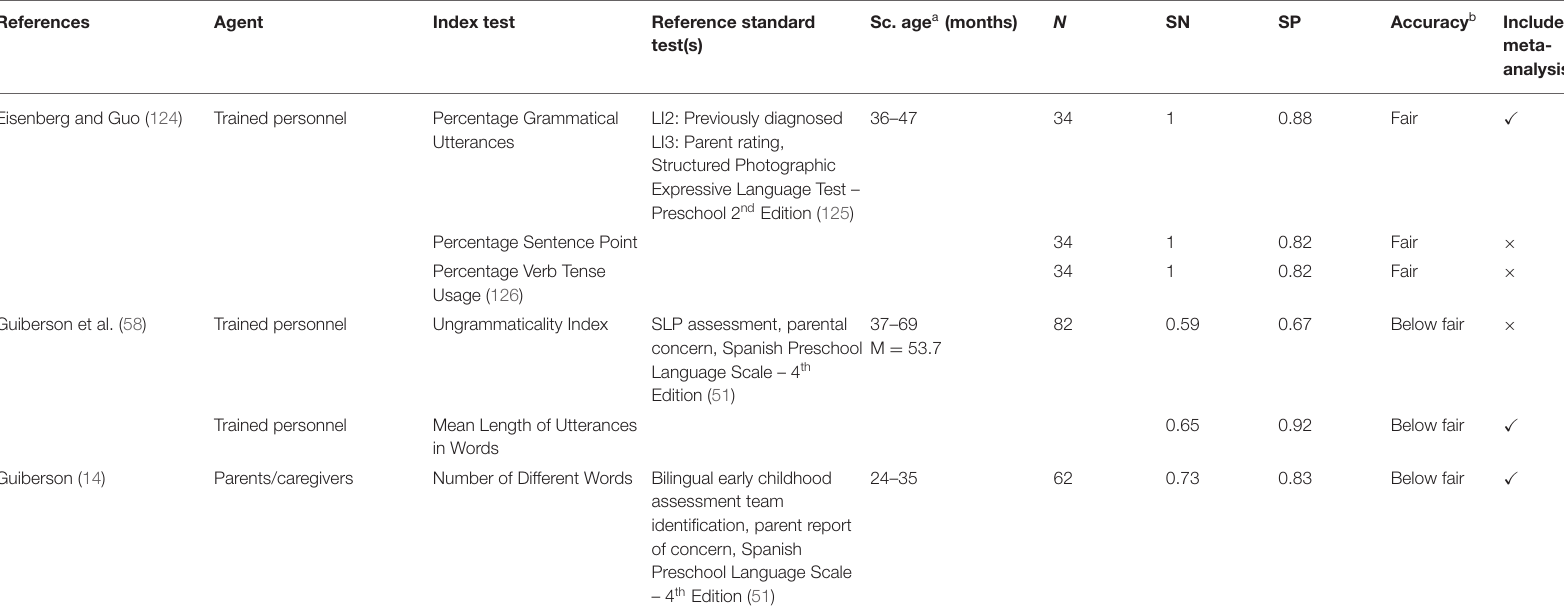
TABLE 4 | Studies involving tools based on language